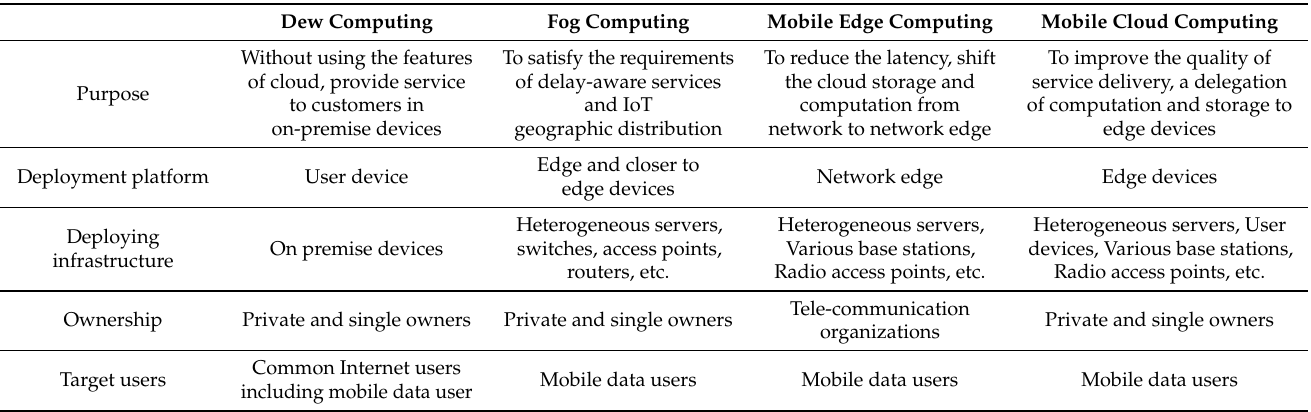
Table 1. Comparison among different edge